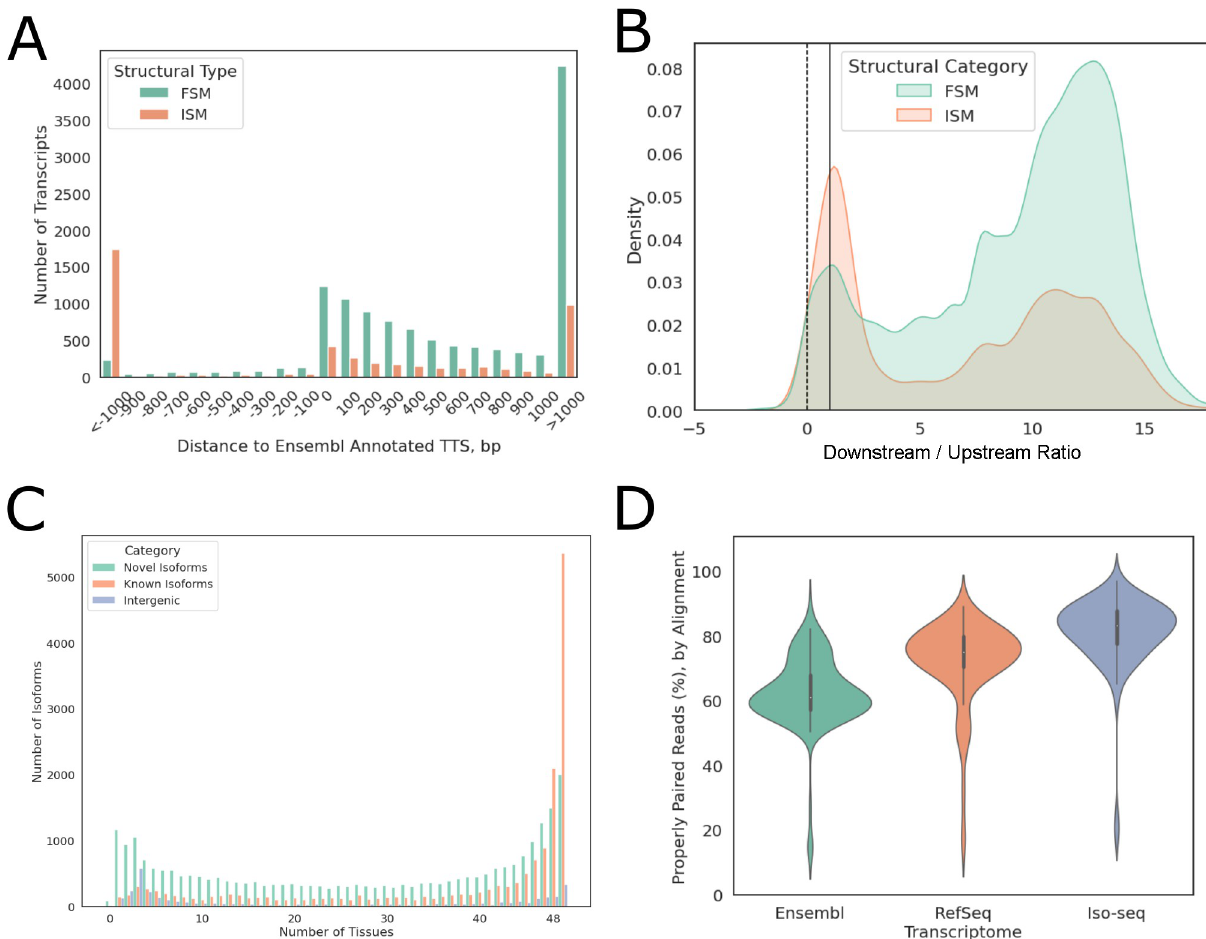
Fig 1. Iso-seq transcriptome improved gene annotation. (A) Distance between Iso-seq Ensembl annotated TTS, negative values indicate shorter 3’ ends. Eg. -1000 indicates that Iso-seq annotated TTS is 1000 bp upstream of Ensembl annotated TTS. (B) Log 2 of 100 bp downstream as compared to upstream of TSS RNA-seq coverage. Positive ratios indicate higher coverage downstream of TSS. The dotted line indicates equal coverage up- and down-stream of TSS while the solid line indicates 100% higher coverage downstream of the TSS than upstream. (C) Distribution of known vs. novel transcripts detected in different numbers of tissues. (D) Distribution of mapping rates against Iso-seq transcriptome vs. Ensembl or RefSeq transcriptome across 57 RNA-seq samples. FSM: full-splice match; ISM: incomplete-splice match; TTS: transcription start site; TSS: transcription termination